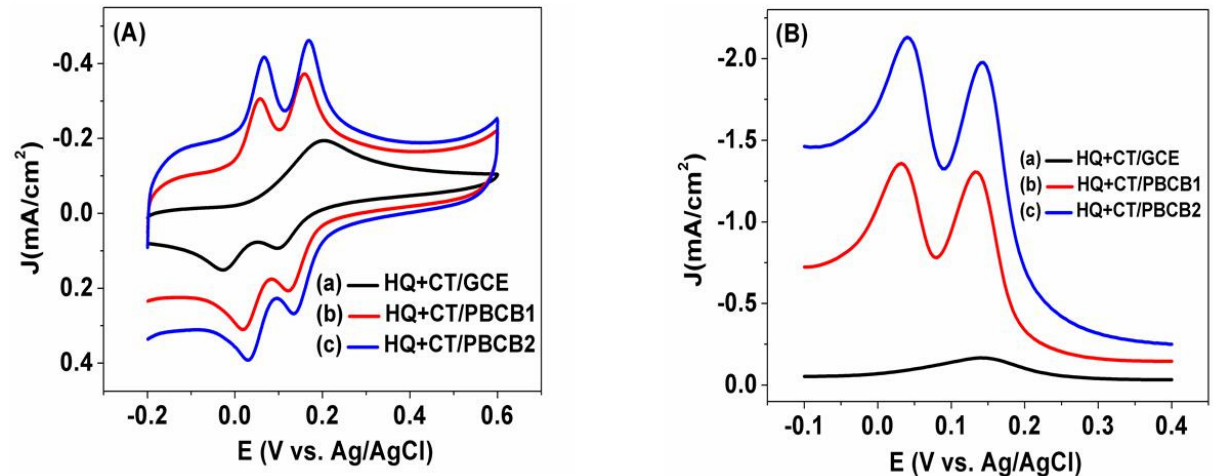
Figure 4. CVs ( A ) and DPVs ( B ) for the mixture solution of HQ (0.50 mM) and CT (0.50 mM) in PBS (pH = 7.0) at GCE (a), PBCB1 (b), and PBCB2 (c). (pH = 7.0) at GCE (a), PBCB1 (b), and PBCB2